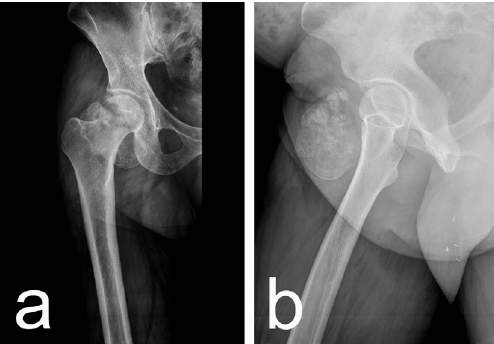
Figure 1. (a, b) Preoperative radiographs showed a well- circumscribed ovoid radiopaque mass.